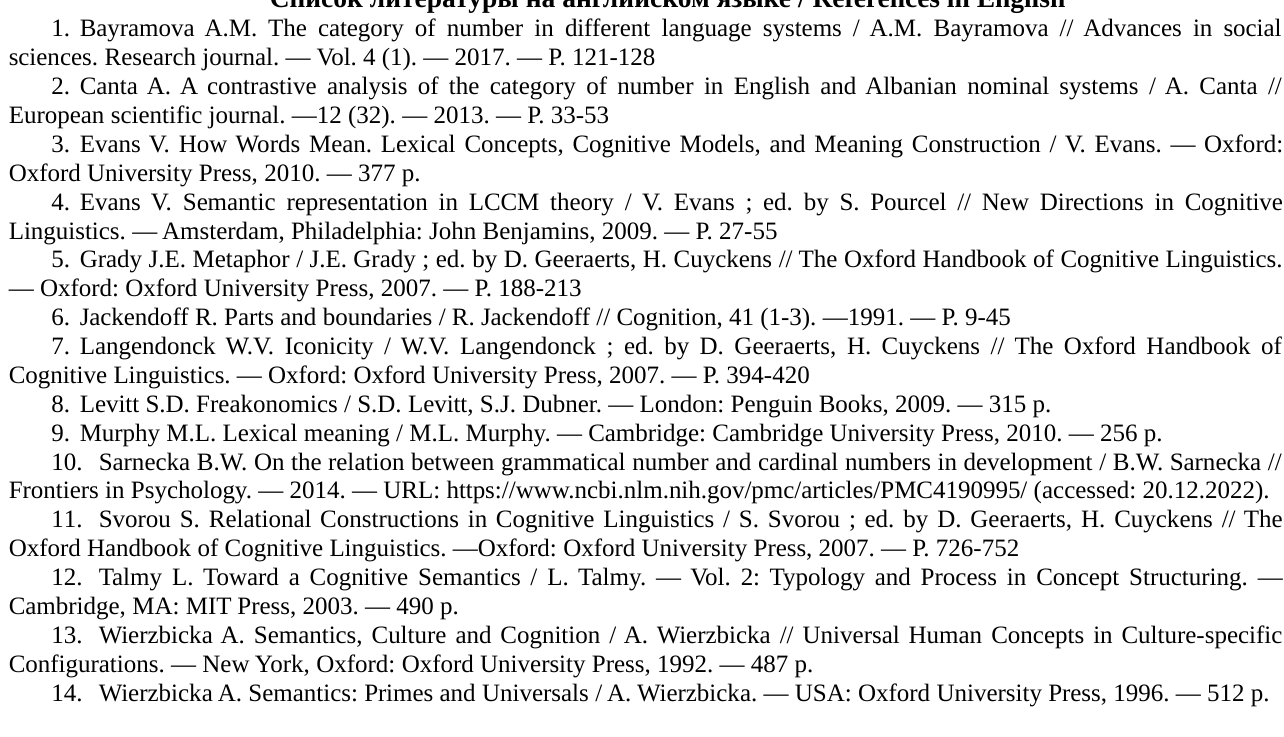
Все статьи проходят рецензирование. Но рецензент или автор статьи предпочли не публиковать рецензию к этой статье в открытом доступе. Рецензия может быть предоставлена компетентным органам по